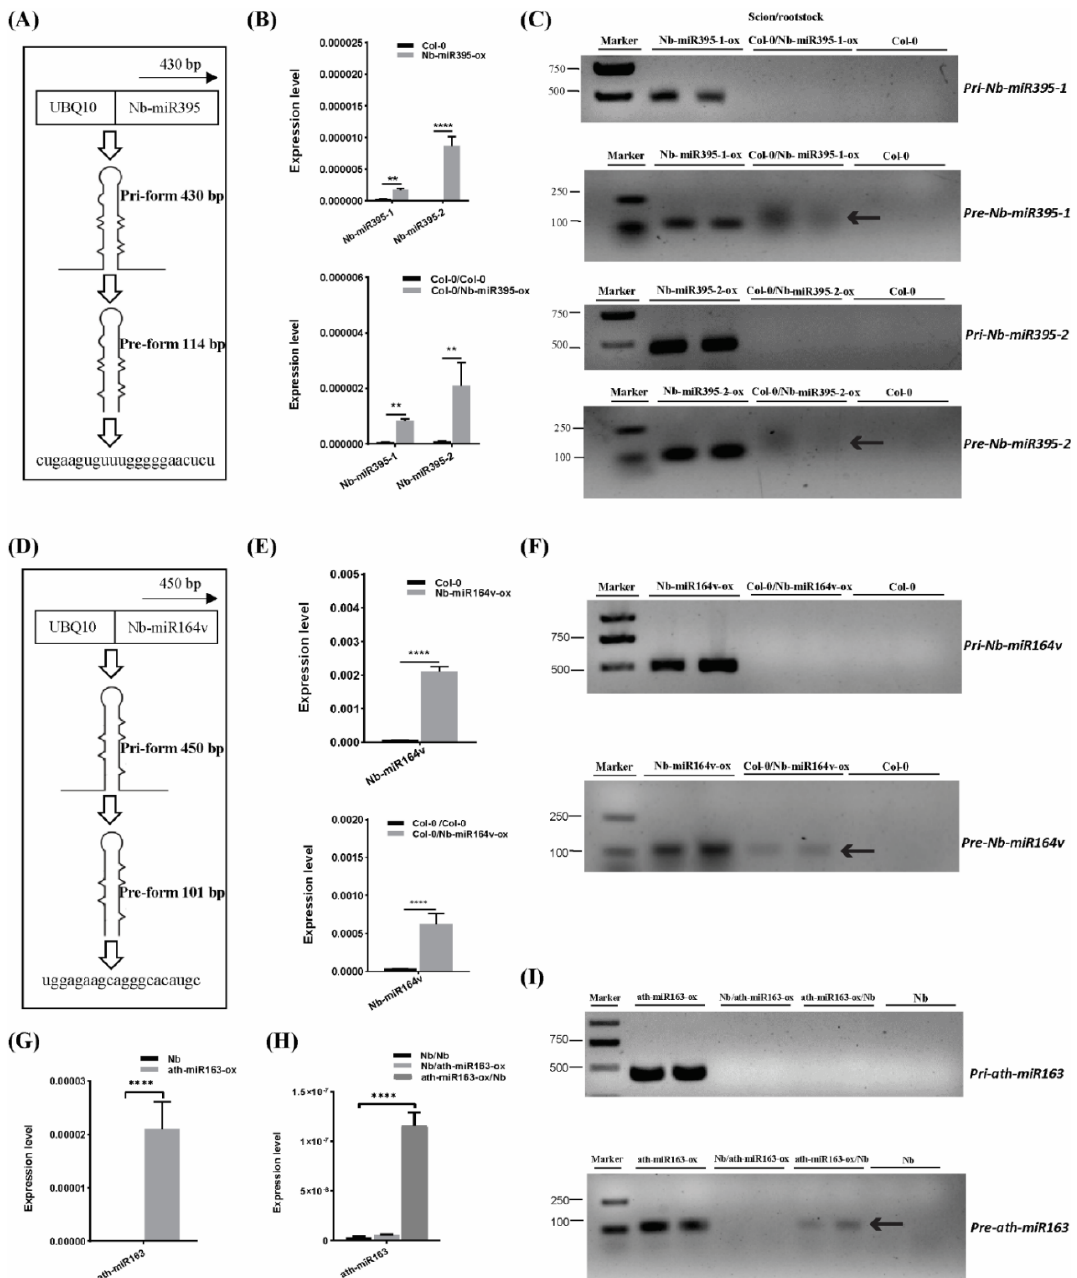
Figure 2. Pre- and mature miRNA detection in the scion. ( A ) Pri and pre forms of Nb-miR395-1 . ( B ) Nb-miR395-1, -2 detection in the Arabidopsis overexpressing line (top) and in the WT Col-0 scion (bottom). ( C ) RT-PCR assays on pri and pre forms of Nb-miR395-1, -2 . ( D ) Pri and pre forms of Nb-miR164v . ( E ) Nb-miR164v detection in the Arabidopsis overexpressing line (top) and in the WT Col-0 scion (bottom). ( F ) RT-PCR assays on pri and pre forms of Nb-miR164v . ( G ) QPCR quantification of ath-miR163 in the Nb overexpressing line. ( H ) QPCR quantification of ath-miR163 in the WT Nb scion and rootstock. ( I ) RT-PCR assays on pri and pre forms of ath-miR163 in the WT Nb scion and rootstock. The arrow indicates the precursor transcript in the WT scion or rootstock. The bars represent the means and standard deviations of six replicates (three biological replicates, each with two technical replicates). The two asterisks indicate p < 0.01, and four asterisks indicate p < 0.0001 ( t -test).